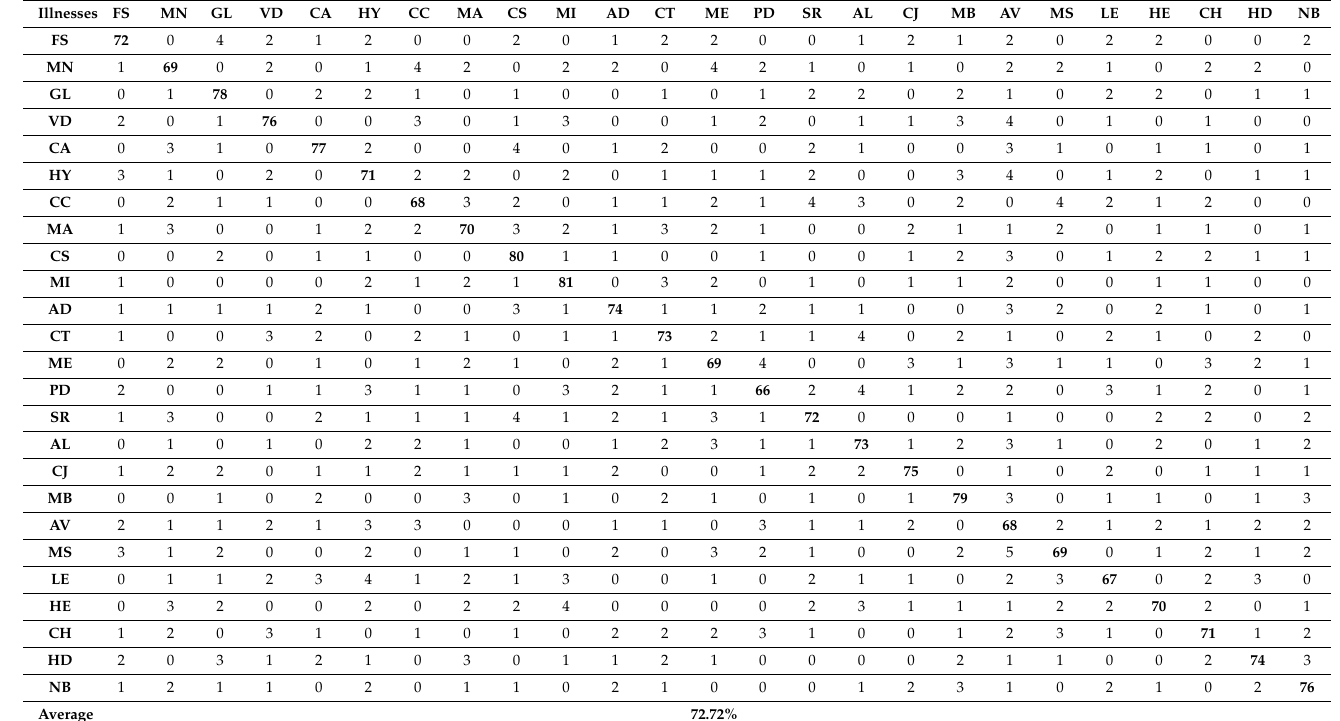
Table 3. Performance of Gray Texture Features method (instead of using the developed approach) using MRI dataset (Unit